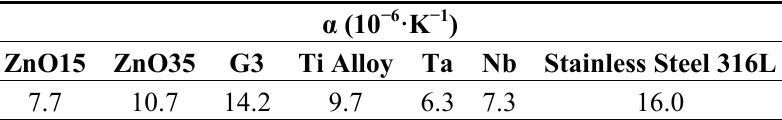
Table 1. Thermal expansion coefficients ( α